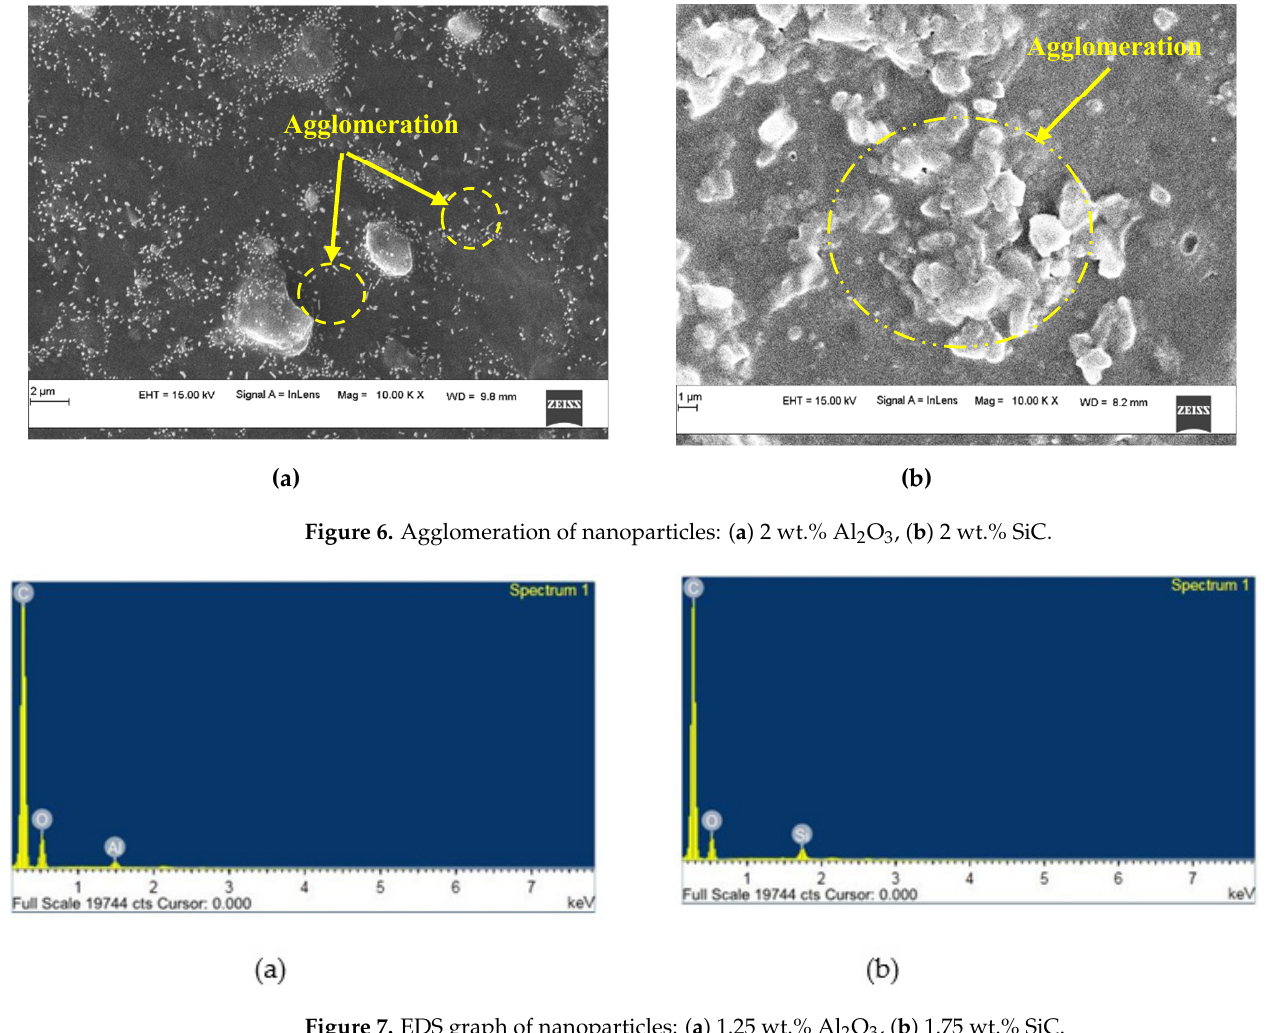
Figure 7. EDS graph of nanoparticles: ( a ) 1.25 wt.% Al 2 O 3 , ( b ) 1.75 wt.% SiC. Table 5. EDS weight ratios of hybrid